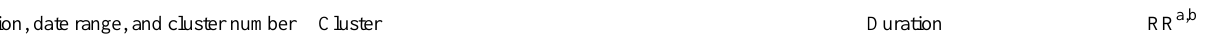
RR a,b DurationClusterRegion, date range, and cluster number